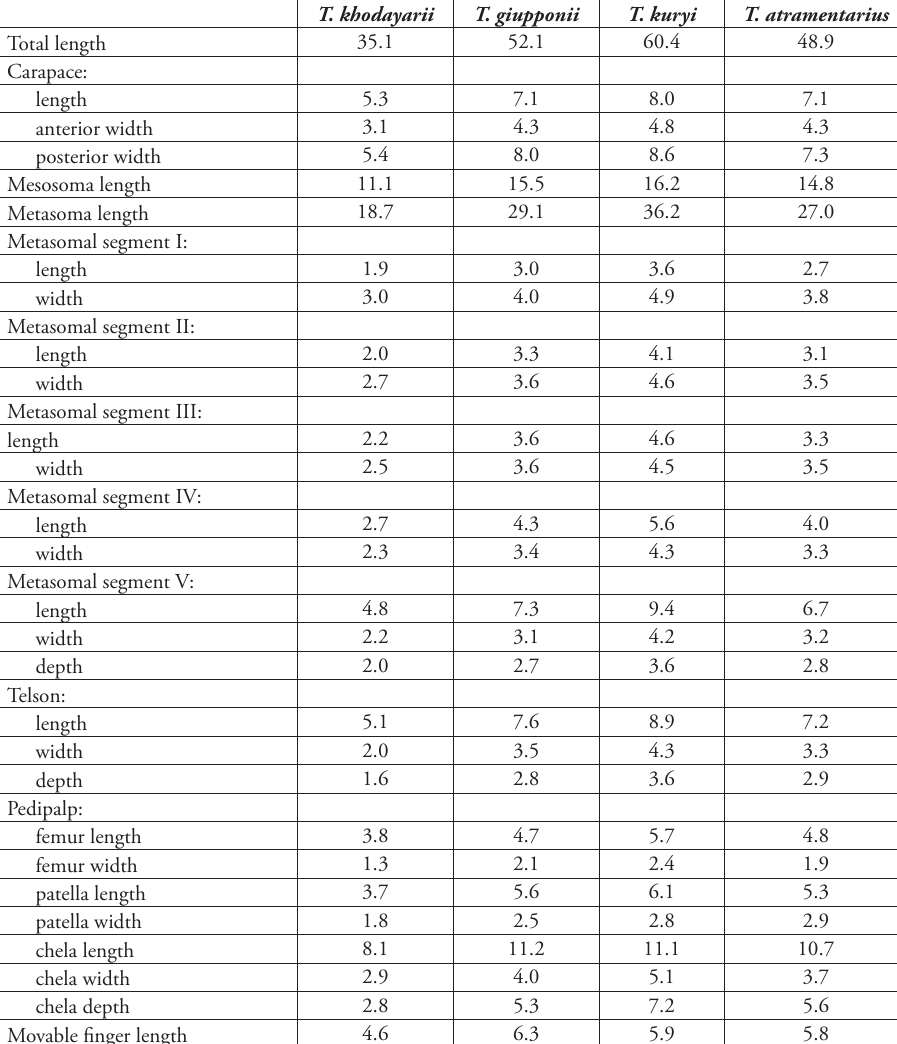
Table 1. Morphometric values (in mm) of female holotypes of T. khodayarii sp. n., T. giupponii sp. n., T. kuryi sp. n., and T. atramentarius Simon, 1878. T. khodayarii T. giupponii T. kuryi T.